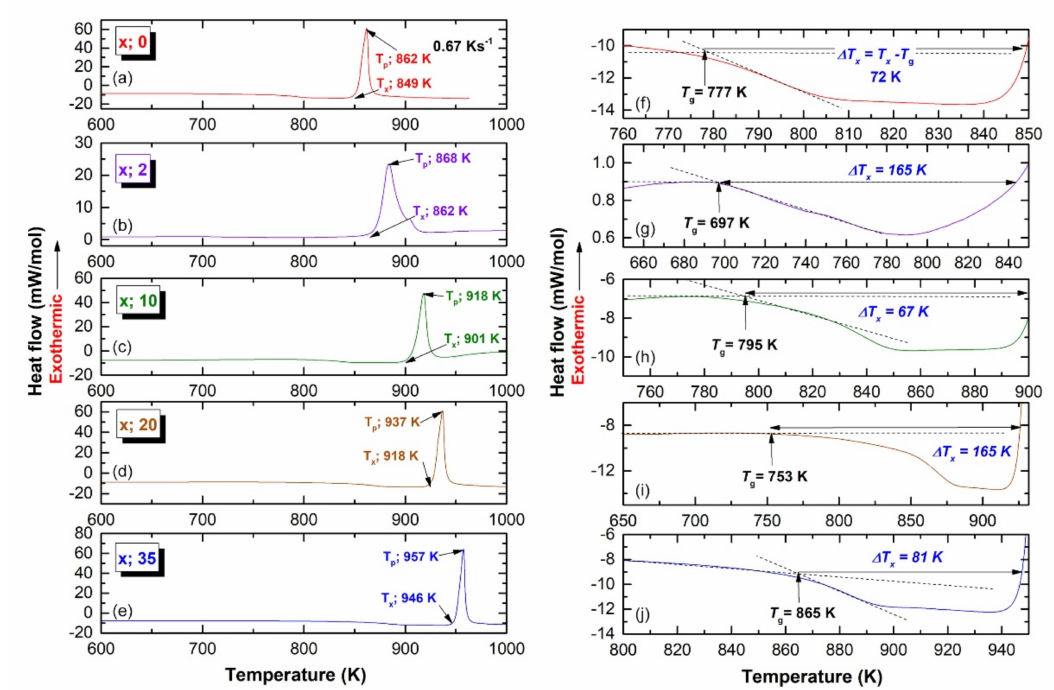
Figure 8. Differential scanning calorimetry (DSC) traces conducted by differential scanning calorimetry (DSC) under He gas flow at a heating rate of 0.67 Ks − 1 for metallic glassy (Zr 75 Ni 25 Al 5 ) 100-x W x powders milled for 100 h with W concentrations of ( a ) 0, ( b ) 2, ( c ) 10, ( d ) 20, and ( e ) 35 at. %. The supercooled liquid region ( ∆ T x ) related to ( a – e ) is displayed with a different scale in ( f – j ). The glass transition temperature (T g ), onset-crystallization (T x ), and peak-(T p ) temperatures, as well as ∆ T x , are indexed in the figure by arrow symbols.